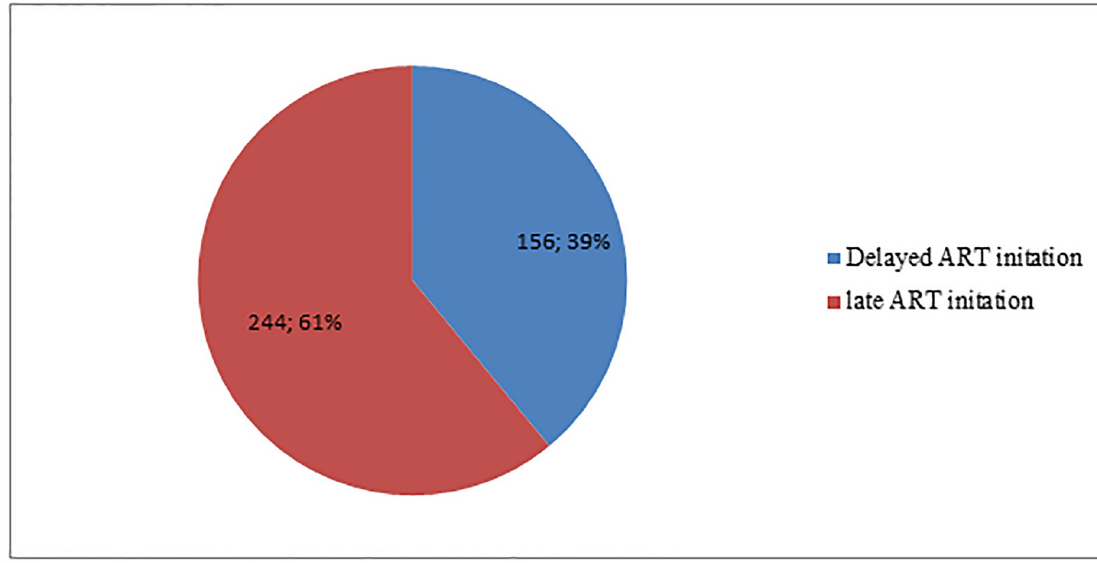
Fig 1. Delayed ART initiation status of adults receiving ART following Test and Treat strategy at public health institutions in Bahir Dar city, Northwest Ethiopia, 2022.